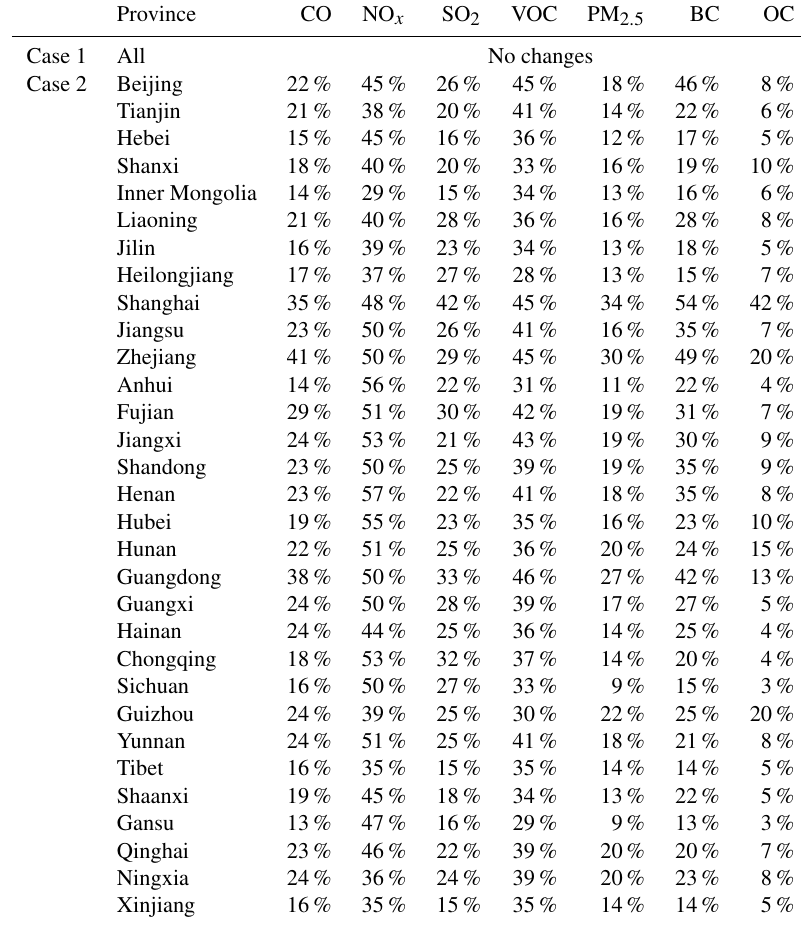
Table 1. Simulation scenarios during the COVID-19 period in this study, based on Huang et al.